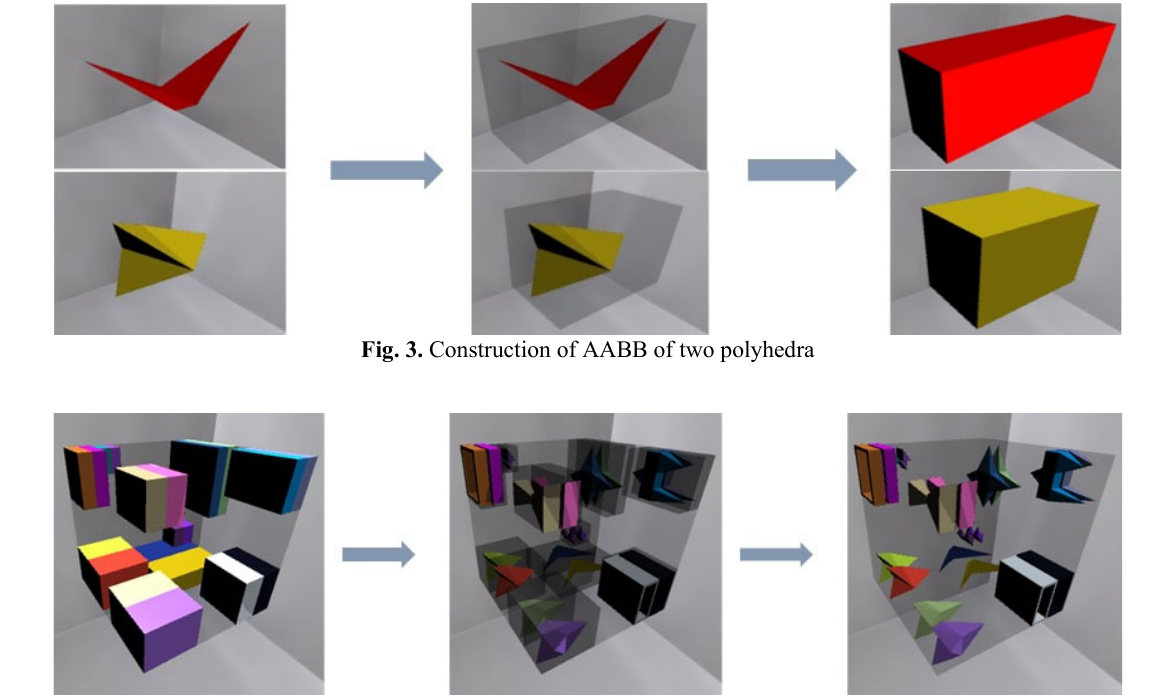
Fig. 4. Replacement of the packed AABB, packed by the algorithm presented in Alvarez Martínez et al. (2015), by the corresponding small items. The instance used in the example is